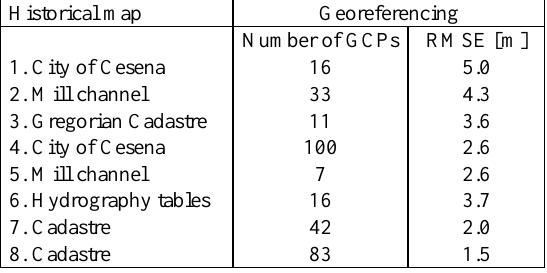
Table 10. Number of GCPs and georeferencing errors